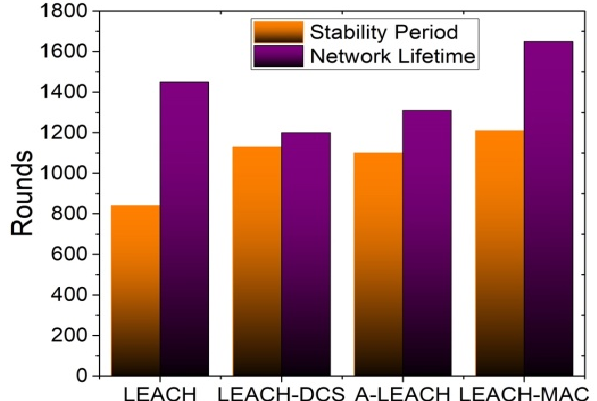
Figure 10. Lifetime metrics comparison for BS location (50,175).